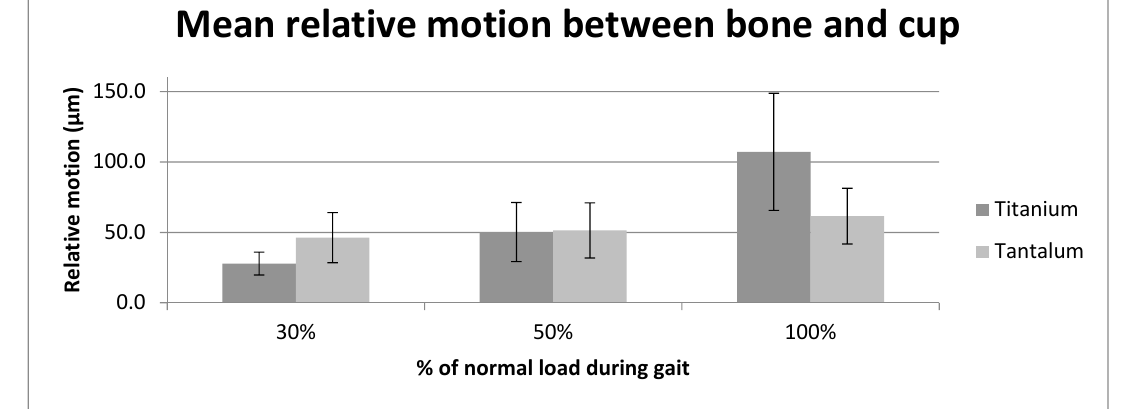
Figure 5. Graph showing the average relative motion ( µ m) between the tantalum and titanium cup and composite bone at the three tested load levels (30%, 50% and 100% load).